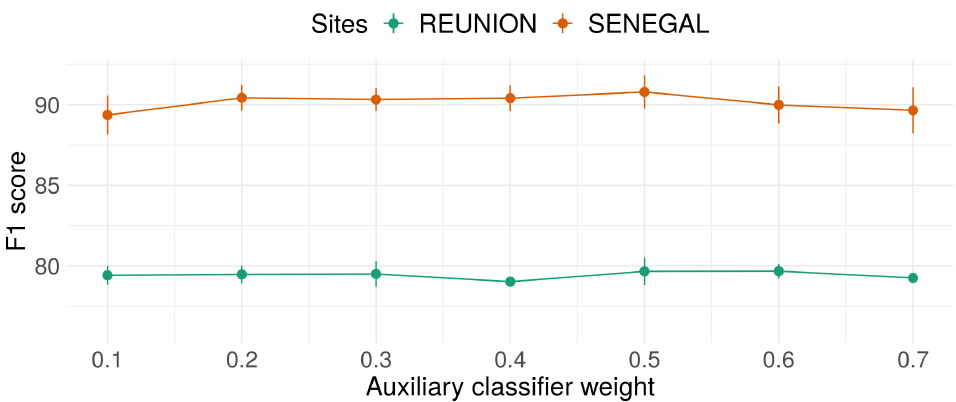
Figure 13. Sensitivity analysis of the α weights that are associated to the importance of the auxiliary classifiers in HOb2sRNN regarding the F1 score. Standard deviation is displayed as error bar.